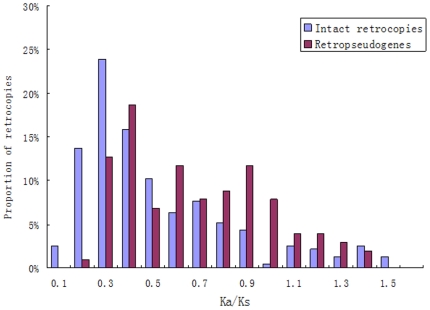
Ka/Ks distributions for intact retrocopies and retropseudogenes in Amphioxus.The Ka/Ks values were obtained through comparing retrocopies and corresponding parental genes.